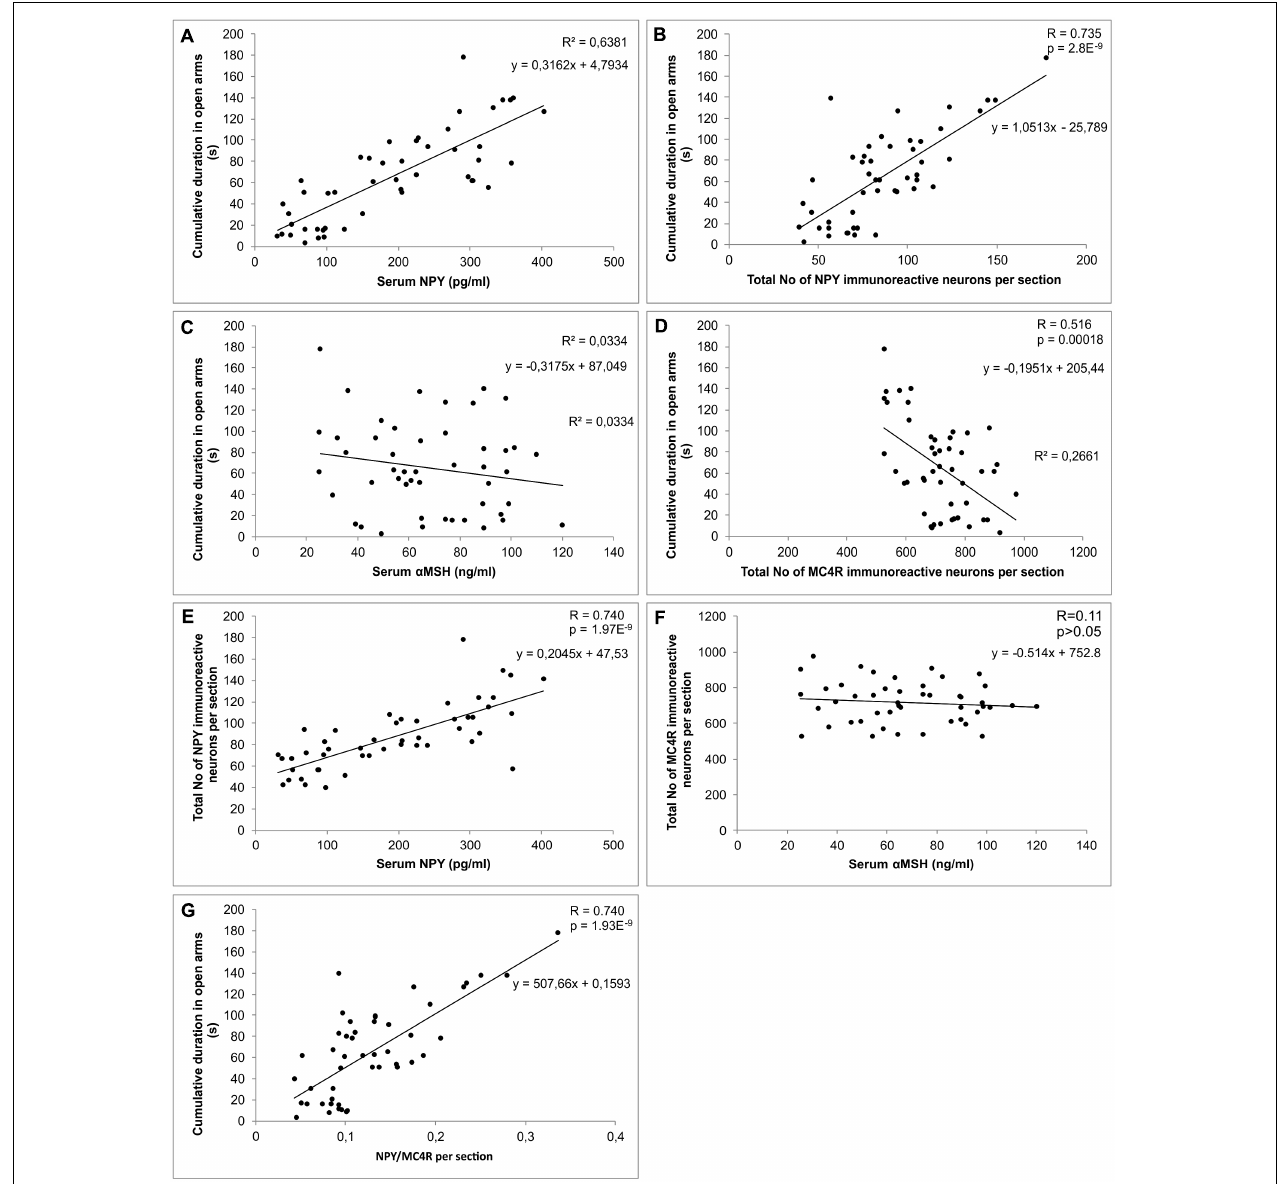
FIGURE 6 | Relationships between biochemical, behavioral and immunohistochemical parameters. (A) serum NPY levels and cumulative duration in open arms, (B) total number of NPY immunoreactive neurons per hippocampal section and cumulative duration in open arms, (C) serum α MSH levels and cumulative duration in open arms, (D) total number of MC4R immunoreactive neurons per hippocampal section and cumulative duration in open arms, (E) serum NPY levels and total number of NPY immunoreactive neurons per hippocampal section, (F) serum α MSH levels and total number of MC4R immunoreactive neurons per hippocampal section, (G) hippocampal NPY/MC4R ratio and cumulative duration in open arms ( n = 48).